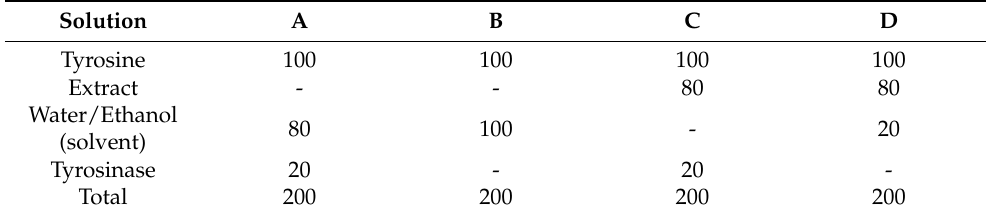
Table 1. Specifications of solution A, B, C, and D for tyrosinase inhibition rate.